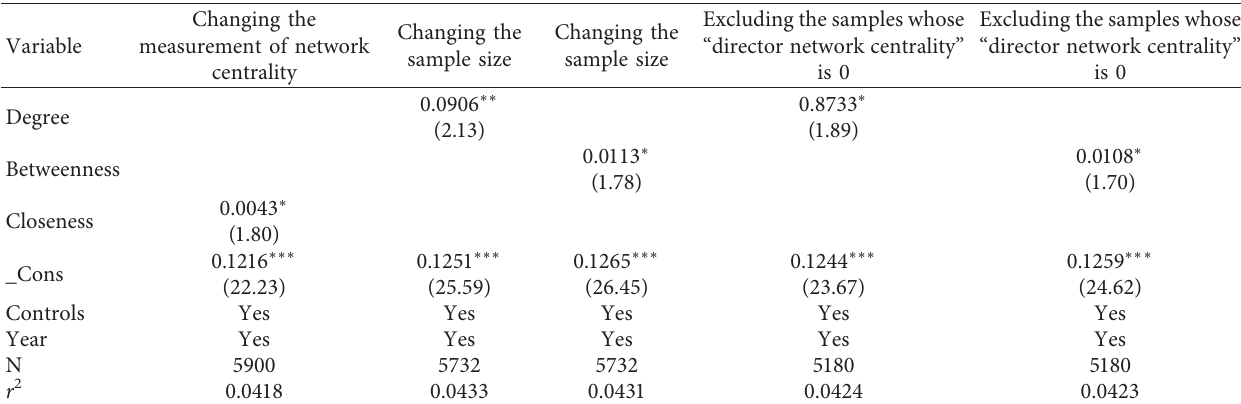
Table 8: Robustness test.